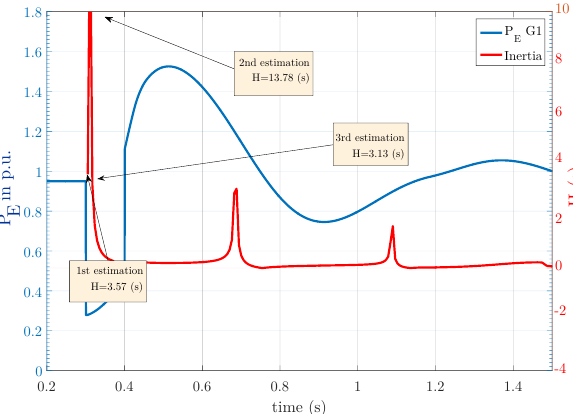
Figure 8. Active power generated by G1 and the behavior of Hestimated.